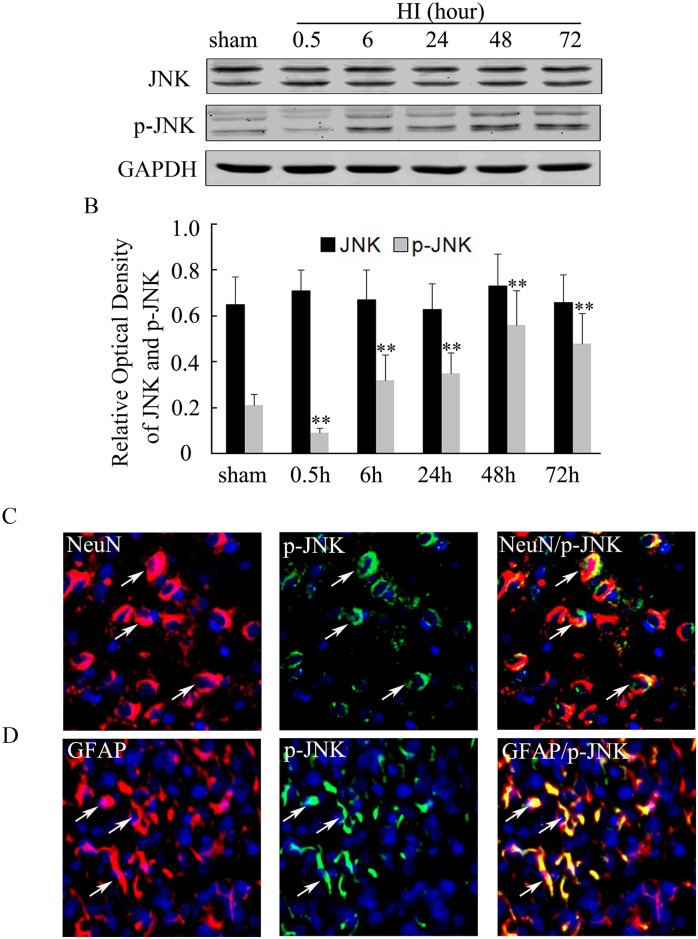
Expression and distribution of p-JNK and JNK proteins in the P7 rat brain after HI as detected by Western blot analysis and fluorescence immunolabeling.Samples were obtained from the cortex. Equal levels of protein samples (100 μg) were loaded, and GAPDH served as a loading control. The values are expressed as the relative optical density and represented as the mean±SD (n = 5). Total JNK protein was not obviously changed at different time points compared with sham controls (A). However, p-JNK protein levels transiently decreased at 0.5 h, increased at 6 and 24 h, peaked at 48 h, and lasted until 72 h (A). The JNK and p-JNK expression levels in the HI groups and sham controls were quantified. The data were obtained by densitometry and normalized to GAPDH. *p<0.05, **p<0.01 compared with the sham control (B). (HI, hypoxia-ischemia). The cell type specificity of p-JNK with double fluorescent immunolabeling (n = 5). p-JNK, the neuron-specific marker NeuN and the astrocyte-specific marker GFAP were visualized using a p-JNK antibody followed by a FITC-conjugated secondary antibody (green) and NeuN or GFAP followed by a TRITC-conjugated secondary antibody (red). The nucleus was stained by DAPI (blue). p-JNK (C, D) immunoreactivity colocalized to neurons (yellow) and astrocytes (yellow) in the ischemic cortex. Scale bar, 50 μm.